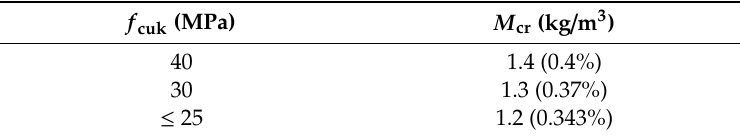
Table 1. Critical concentration value of chloride ion in concrete